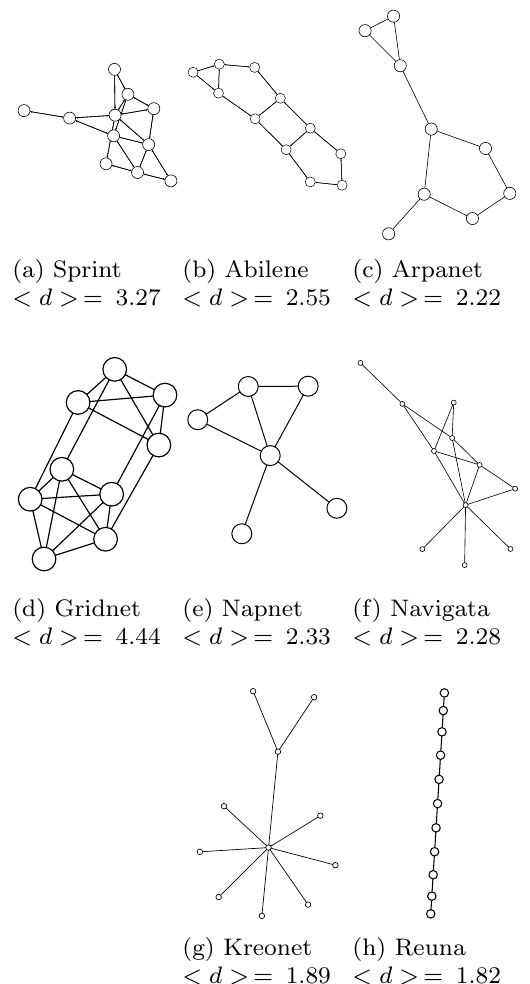
Figure 1: Networks topologies used for placement methods evaluation. Figure 6. Networks topologies used for placement methods